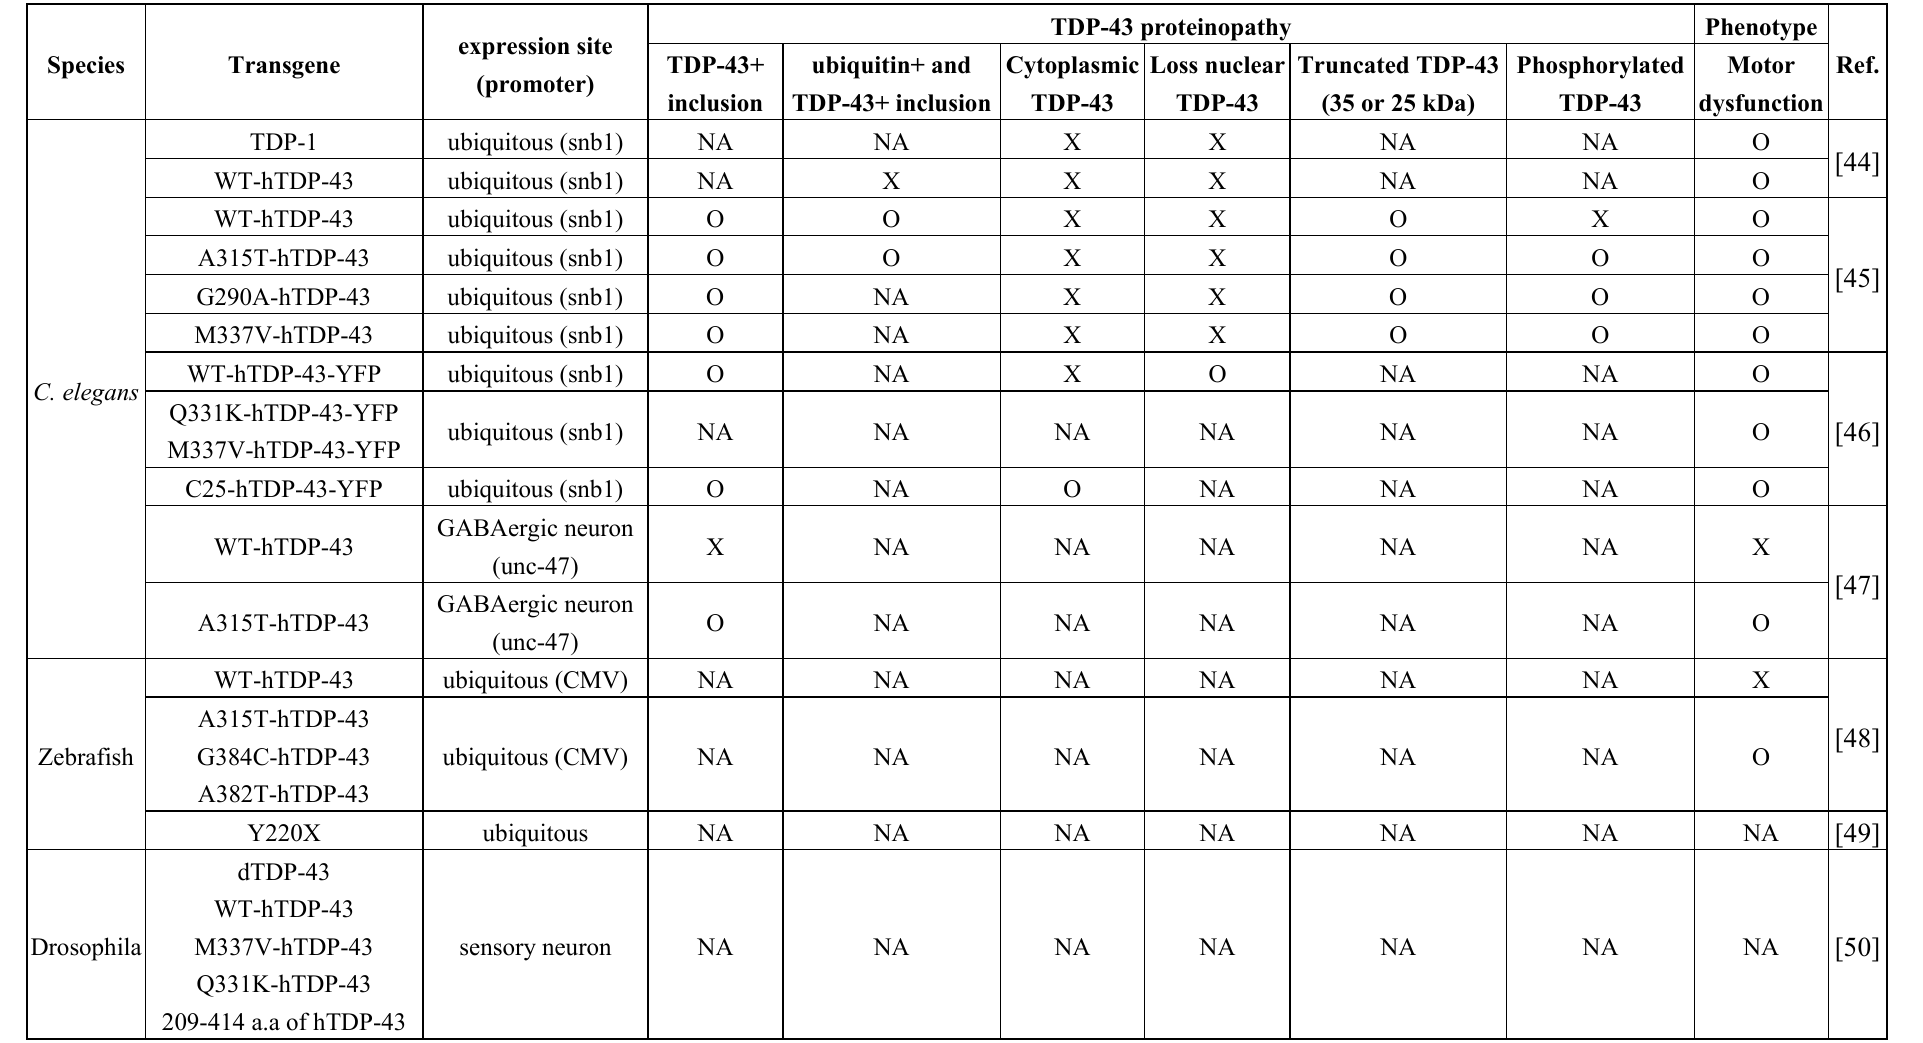
Table 4. Non-mammalian model: wild-type or mutant TDP-43 expression by transgenic animals (NA: non-analysis).